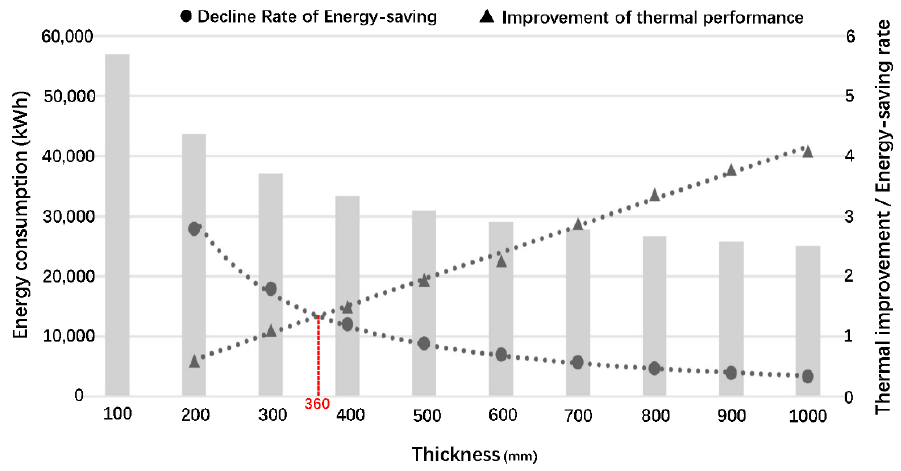
Figure 12. Energy demands of different wall thicknesses.